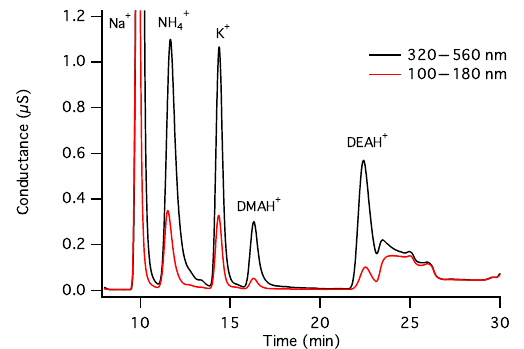
Figure 4. Overlaid chromatograms of MOUDI size-fractionated particle samples collected in St John’s on 6 July 2013 during the intrusion of a biomass-burning plume that originated from north- ern Labrador and Québec. The robustness of the separation method for MMAH + , DMAH + , and DEAH + from the common inorganic cations is demonstrated for the 320–560 (black) and 100–180nm (red) size bins.